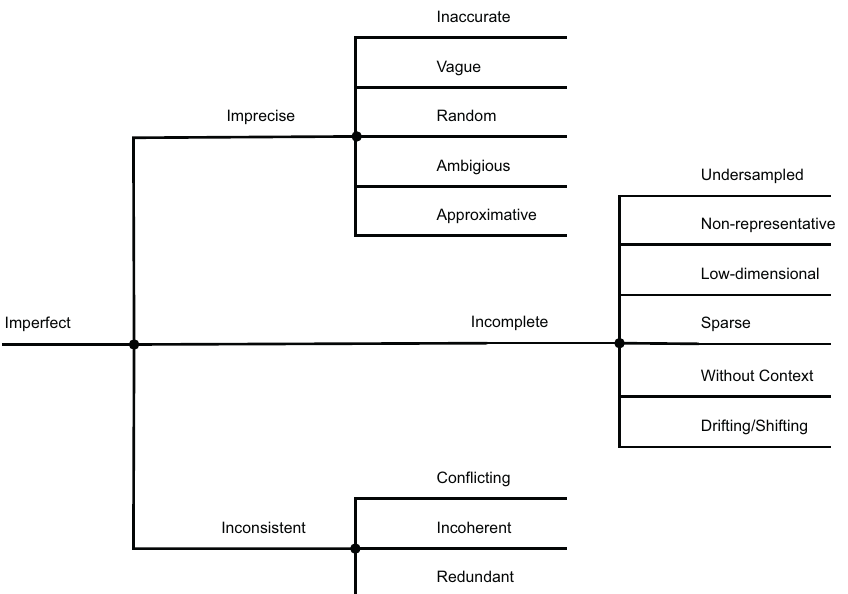
Figure 1. A typology of data and information imperfection with a detailed subcategorisation of incompleteness. The typology is based on the work of Smets’ [23]. It recognises incompleteness as one of three major sources of imperfection – besides inconsistency and imprecision. Imprecision captures deficiencies that prevent unambiguous statements from being made based on individual data points. Inconsistency refers to situations in which a piece of information is contradictory to existing knowledge or with other information sources. Incompleteness is lacking, absent, or non-complete data and information.